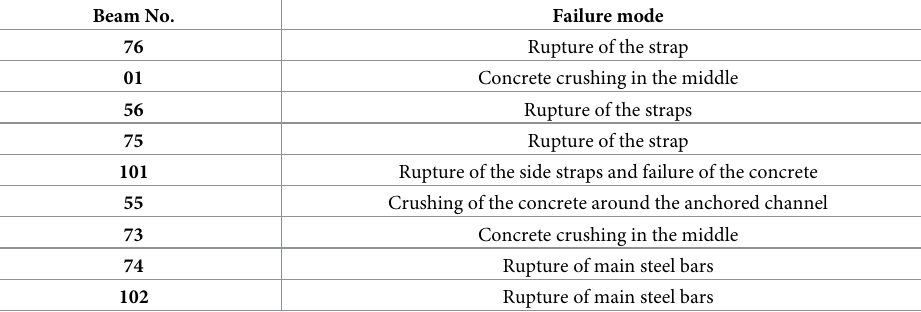
Table 7. Failure mode and crack pattern of the beams. Beam